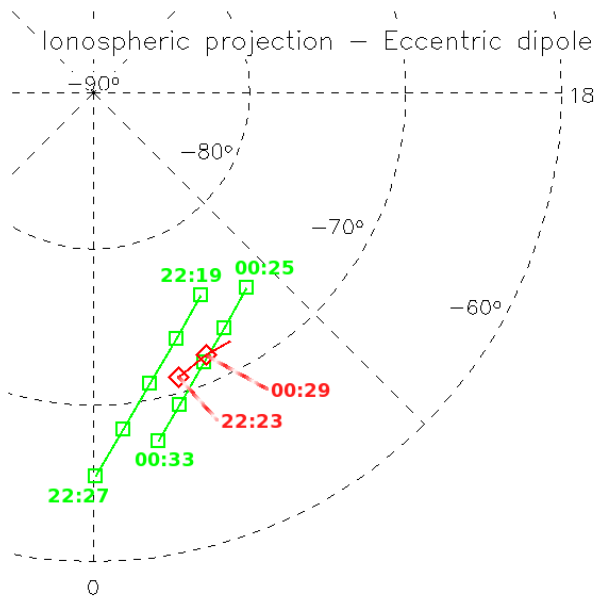
Fig. 2. Trajectories mapped to the ionosphere (110km altitude) of Cluster S/C 1 (red) and the FAST satellite (green) for the two conjunctions at 22:23 UT (19 September 2001) and 00:29 UT (20 September 2001). Every 2min a green square is plotted to indi- cate the FAST location. The T96 magnetic field model is used for the